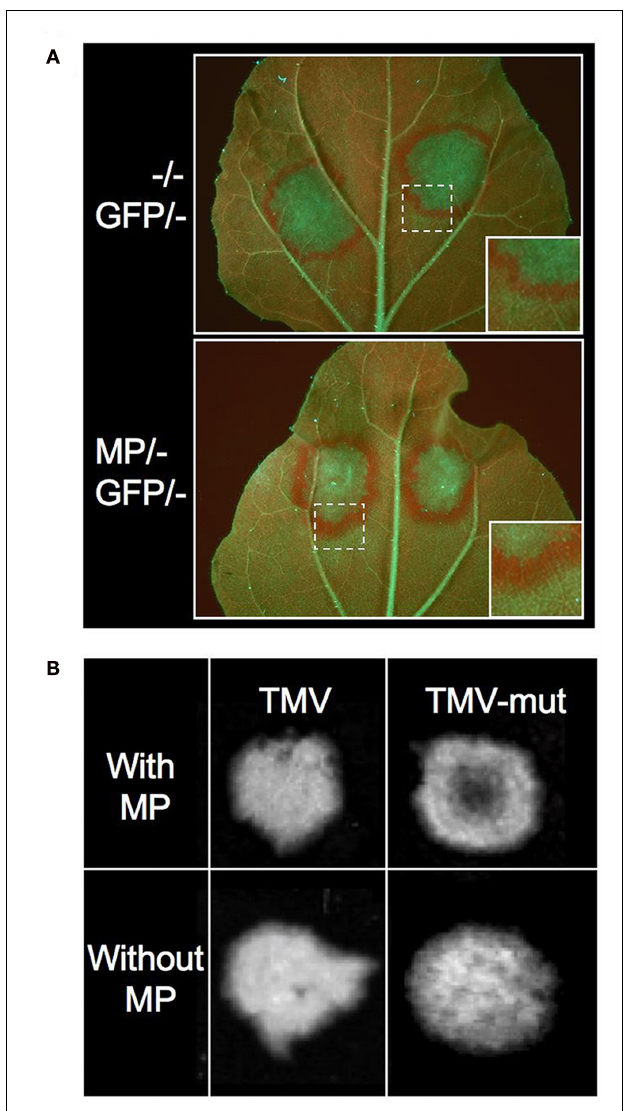
FIGURE 3 |The MP ofTMV is aViral Enhancer of RNA silencing (VER). (A) GFP expression in leaves of GFP-transgenic Nicotiana benthamiana line 16c upon transient expression of 35S::GFP. GFP overexpression induces GFP silencing in the agroinfiltrated patch and triggers the formation of a GFP silencing signal that spreads into surrounding cells.The disappearance of GFP leads to the exposure of strong red chlorophyll autofluorescence. The rim of red fluorescence around the agroinfiltrated patch is broader in tissues expressing the MP (stably or transiently).This indicates that MP enhances the spread of silencing from incipient to recipient cells. (B) GFP-fluorescentTMV infection sites in MP-transgenic plants. Inactivation of theVSR by a missense mutation in the small replicase subunit (TMV-mut) results in silencing of the virus in the center of spreading infection sites in leaves.This central silencing no longer occurs when the MP is deleted.This indicates that viral MP acts by enhancing antiviral silencing. (Figures